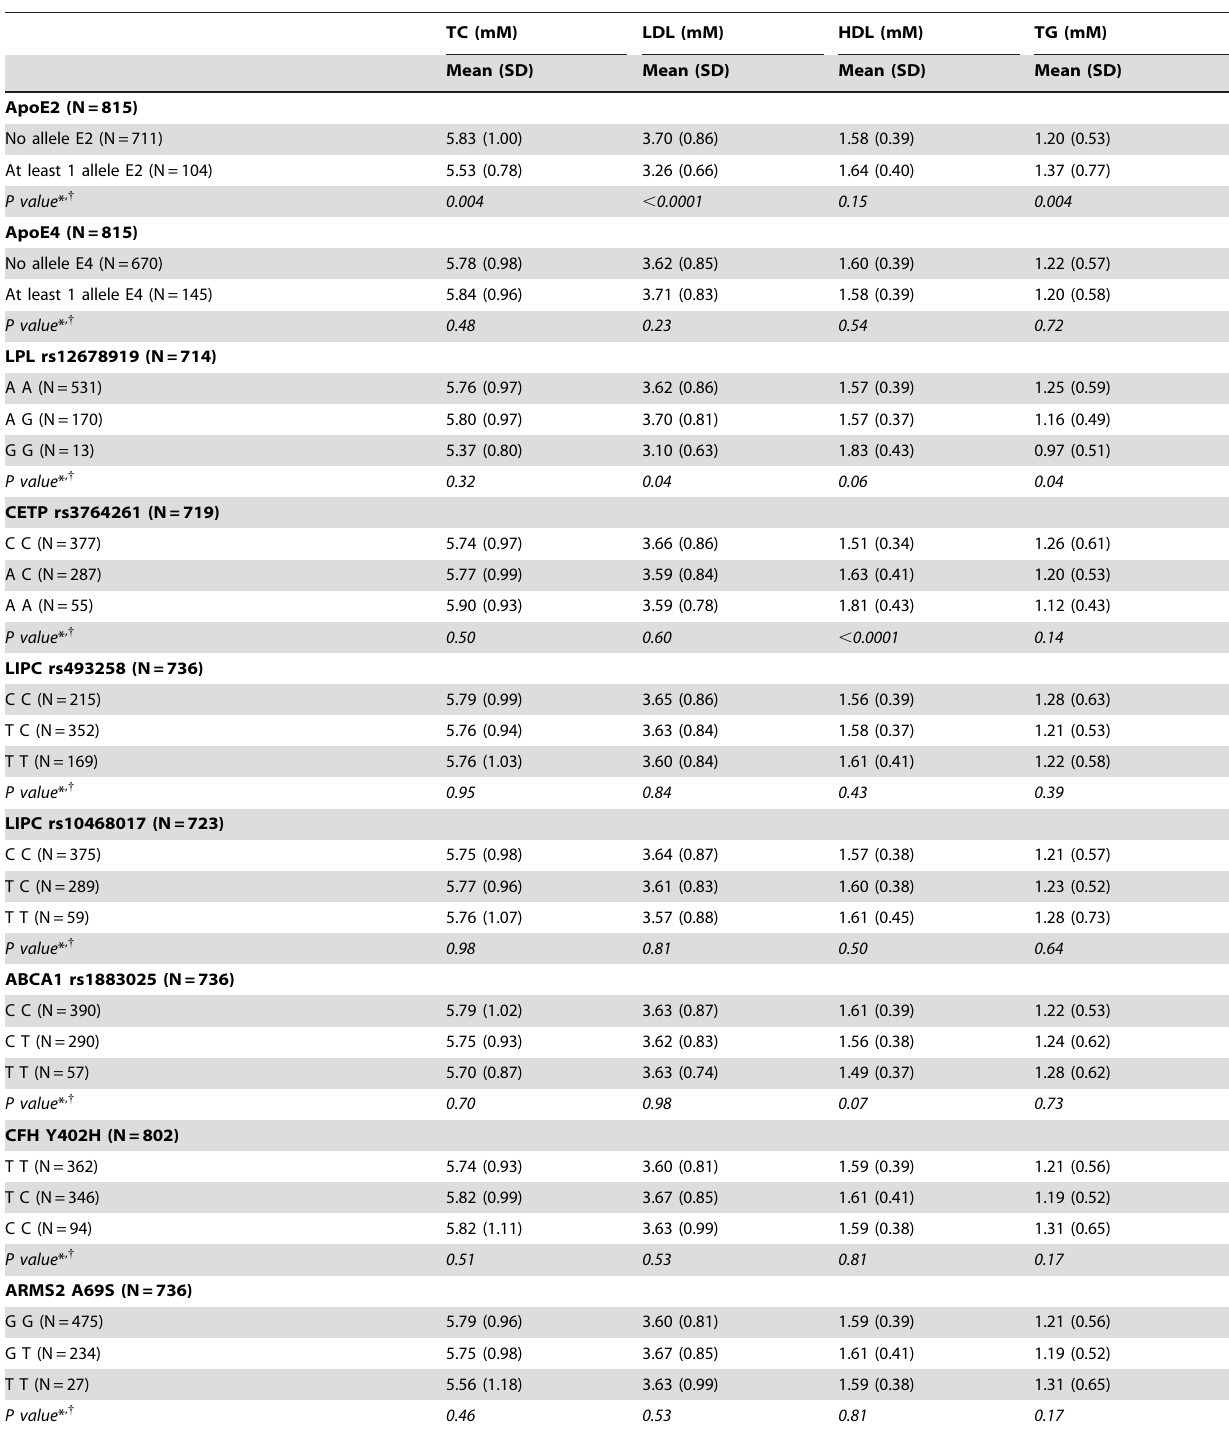
Table 2. Plasma lipid levels according to genetic characteristics in subjects of the Alienor study (N=